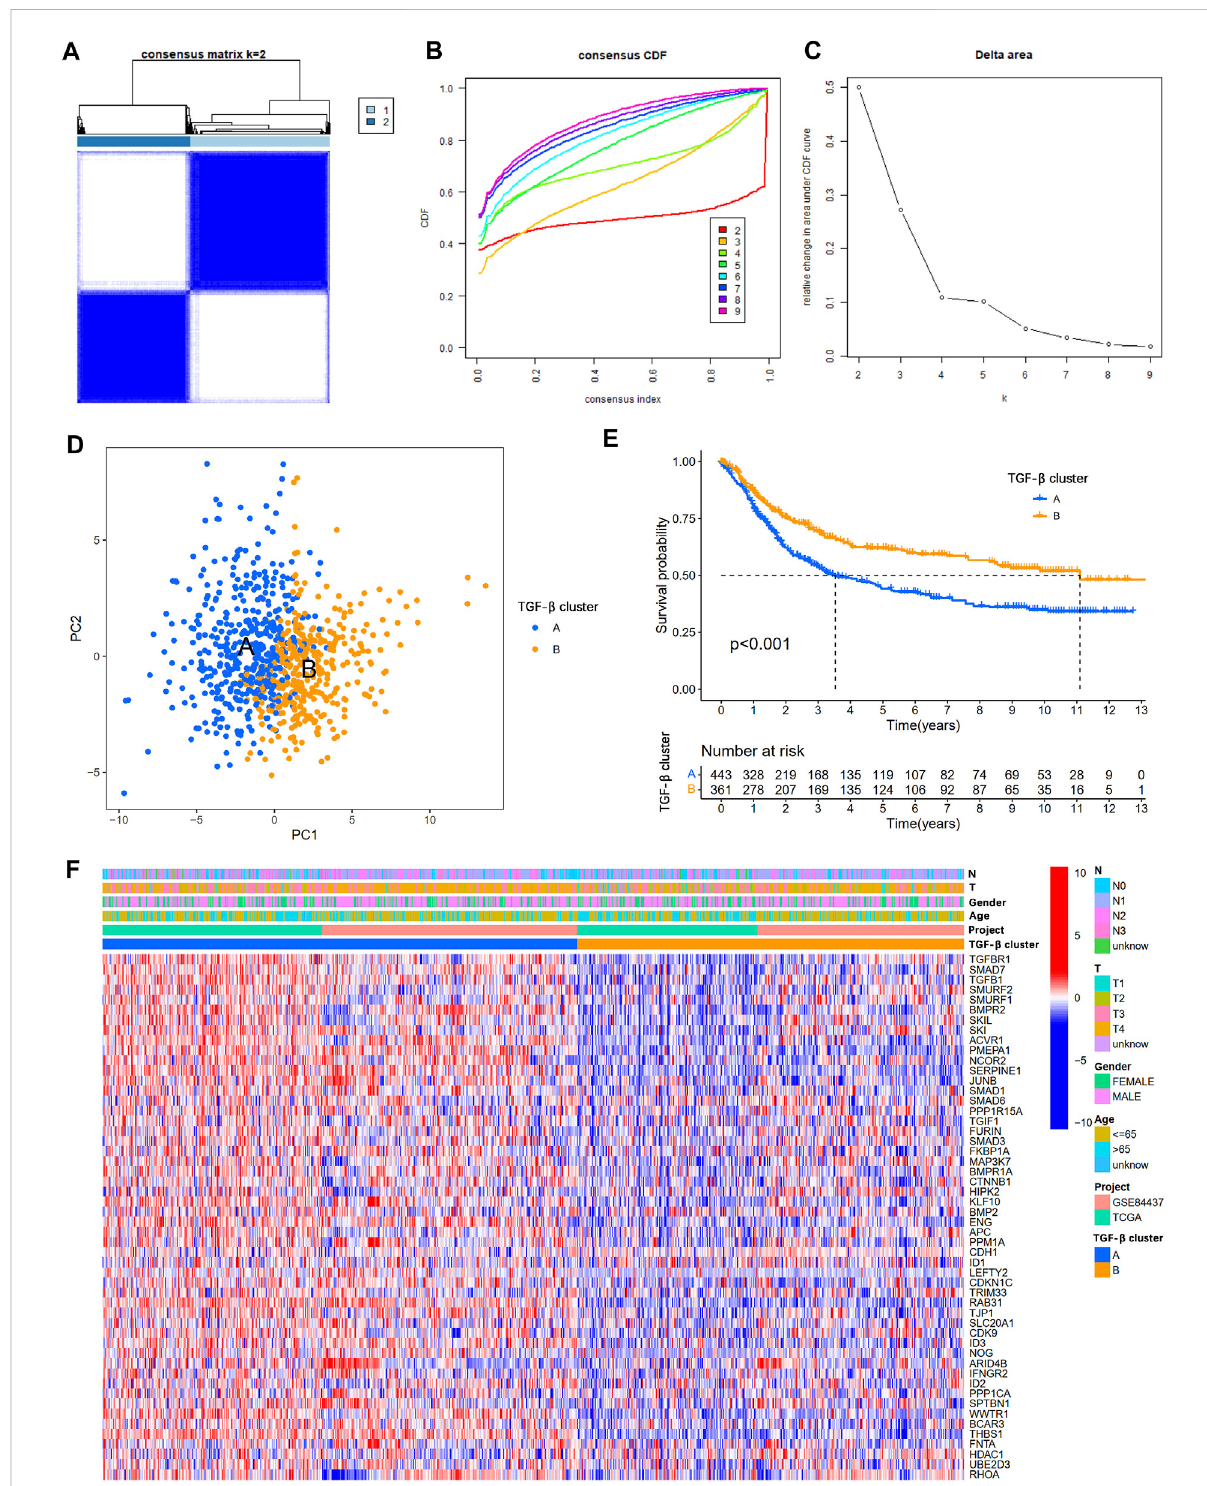
FIGURE 2 Overall survival and clinicopathological characteristics of two different TSRG subgroups. (A) Consensus matrix heatmap de fi ning two clusters ( k =2). (B) Thecumulativedistributionfunction(CDF)from k =2to9. (C) RelativevariationoftheareaundertheCDFregionat k =2 – 9. (D) PCAshows different distributions between the two subgroups. (E) Kaplan-Meier survival analysis between two different TSRG subgroups. (F) Differences in clinicopathologic characteristics and expression levels of TSRGs between the two distinct TSRG subgroups. TSRGs, TGF- β signaling related genes; CDF, cumulative distribution function; PCA, principal components